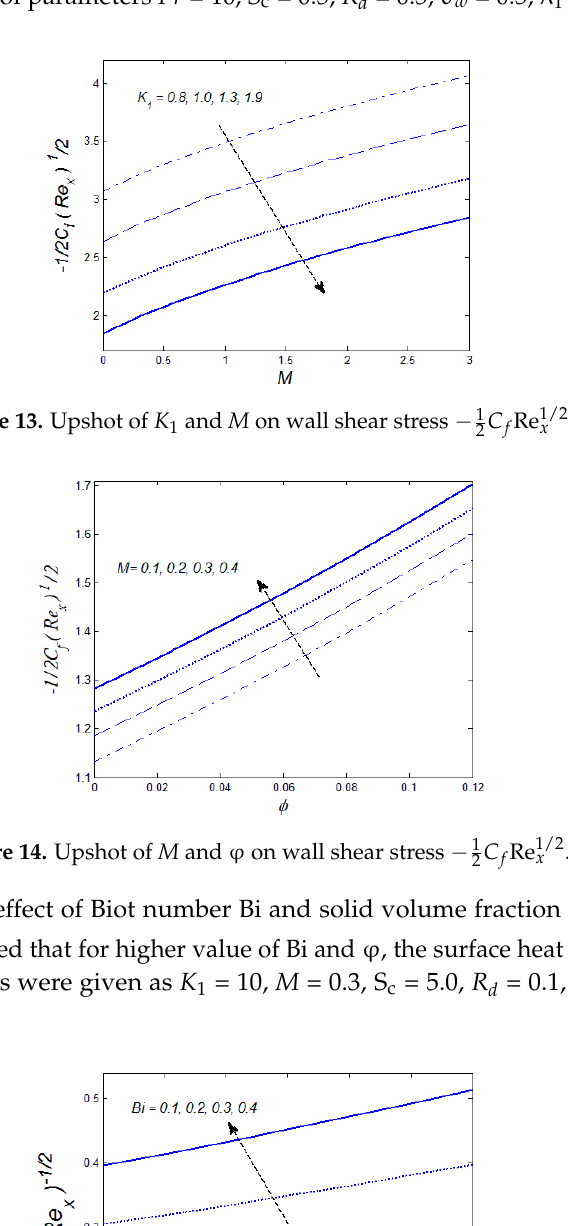
. Figure 15. Upshot of Bi and on ϕ Nusselt number NuRe − 1/2 x x . x . x